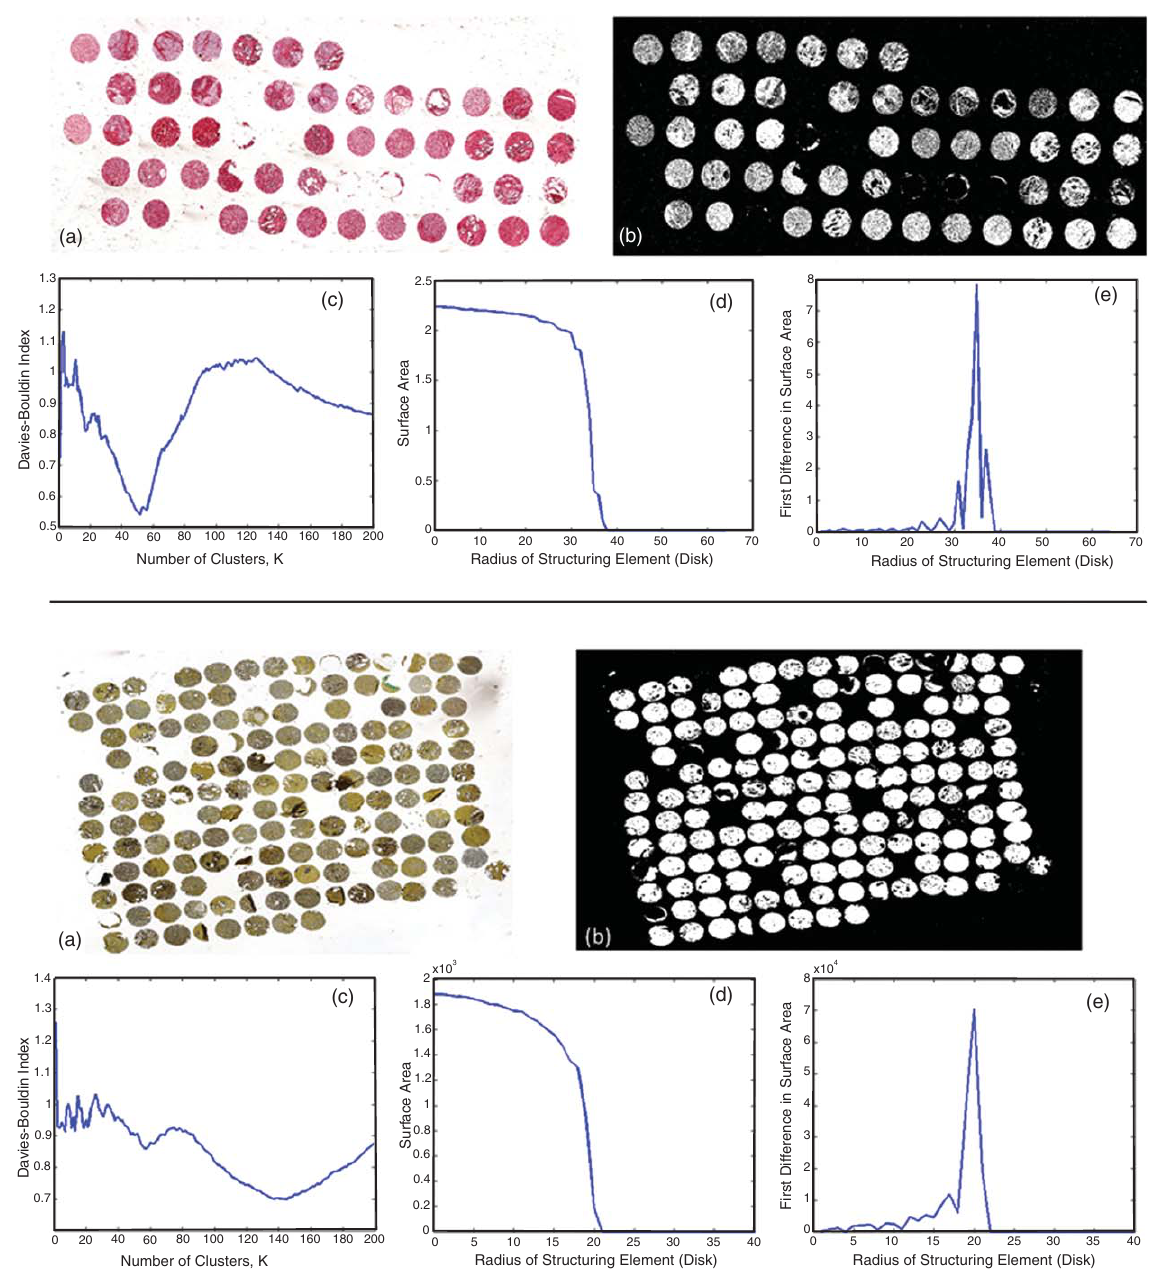
Fig. 2. An illustration of morphological granulometry. (a) Original TMA image. (b) Global thresholding by Otsu’s method. (c) Davies-Bouldin index versus number of clusters. (d) Granulometry function. (e) Object size distribution. with Euclidean distance metric wherein the distance between two clusters C i and C j is given by d ( C i , C j ) = max { d ( x, y ) : x ∈ C i , y ∈ C j }